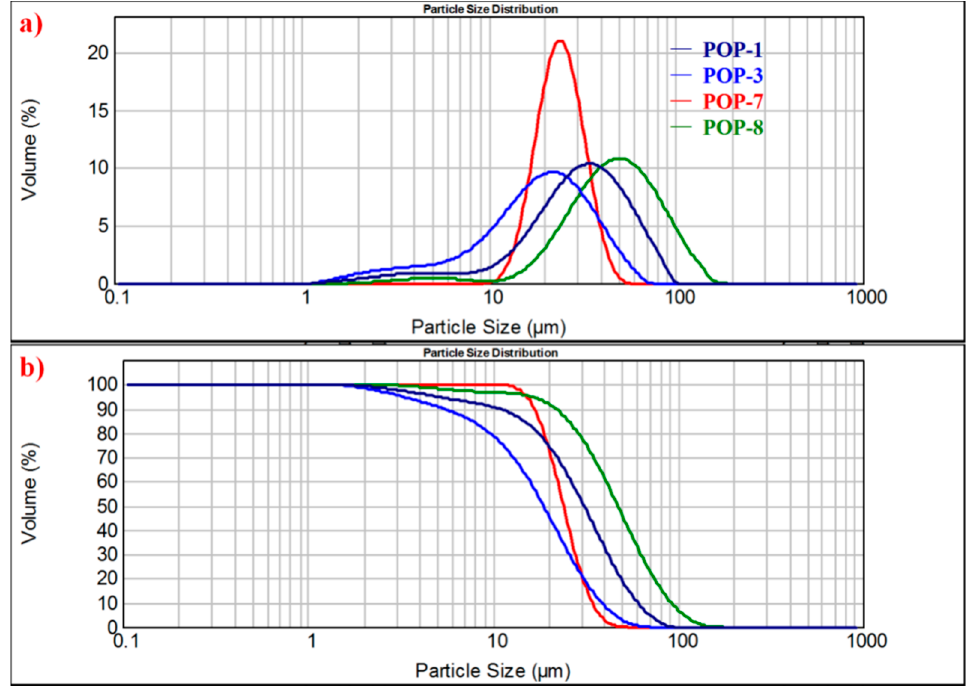
Figure 6. Particle size distribution curves of the prepared TiO 2 /POP particles. ( a ) Particle size distribution curves of POP-1/POP-3/POP-7/POP-8. ( b ) Cumulative curves of POP-1/POP-3/POP-7/POP-8.